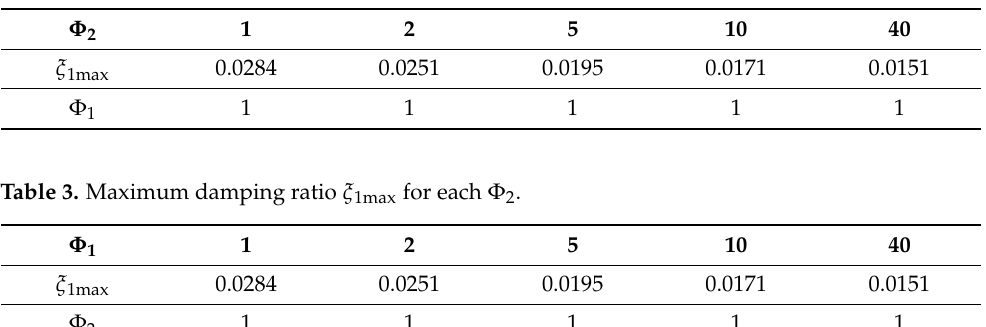
Figure 5. Relationship between Φ 1 , Φ 2 and ξ 1 . Table 2. Maximum damping ratio ξ 1max for each Φ 1.